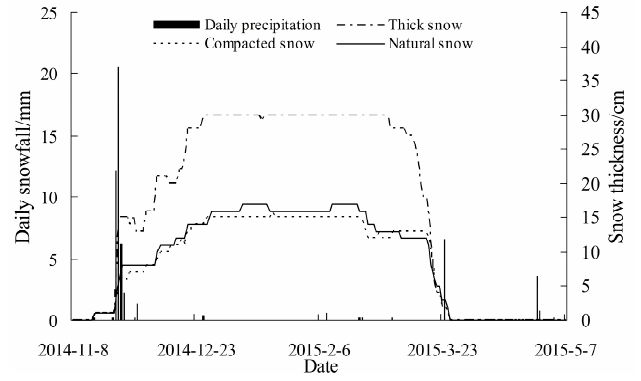
Figure 2. Snow amount and thickness variation in the test period.